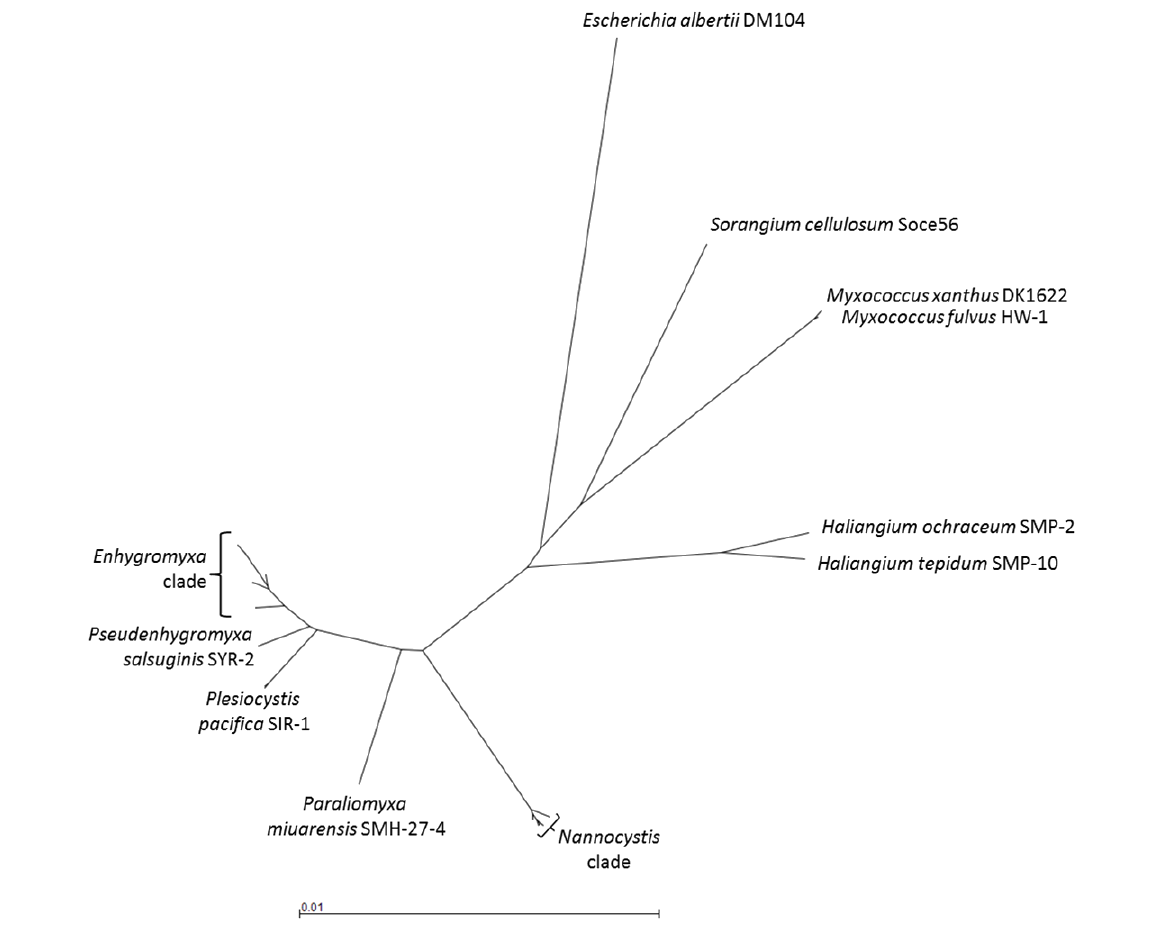
Figure 5: Phylogenetic tree of halotolerant and halophilic myxobacteria. The neighbor-joining tree is based on a multiple sequence alignment (MSA) of the 16S rDNA sequences. The terrestrial myxobacteria Myxococcus xanthus DK1622 and Sorangium cellulosum Soce56 as well as Escherichia albertii DM104 are included for comparison (see Supporting Information File 1 for the sequences used; the MSA was computed using Clustal